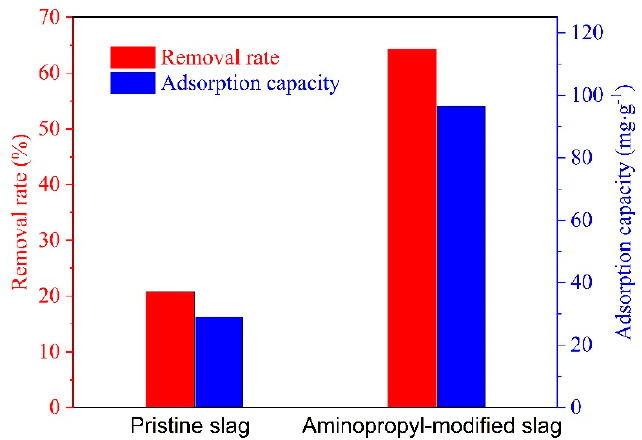
Figure 10. The comparison of the adsorption performance between the pristine and aminopropyl- modified slag. Table 11. Comparison of the lead ion removal performance of various